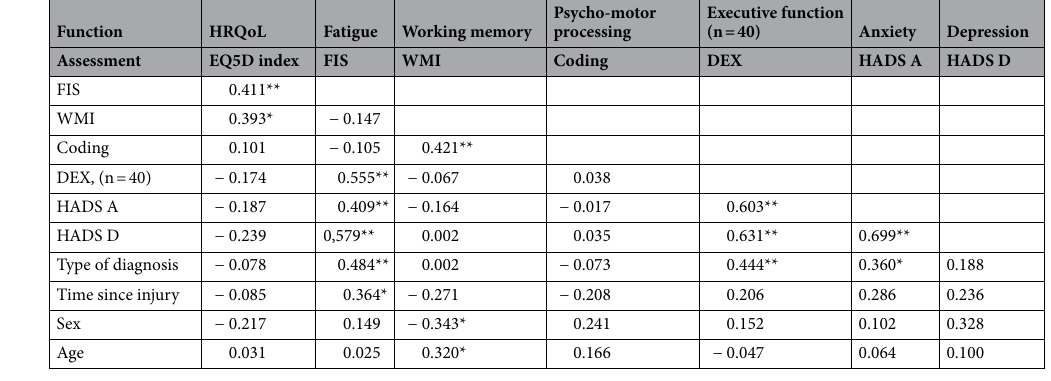
Table 3. Spearman’s rank order correlation between assessments and background factors in the participants with acquired brain injury (n = 41). Spearman’s rank order correlation (sign. 2-tailed) *p ≤ 0.05, **p ≤